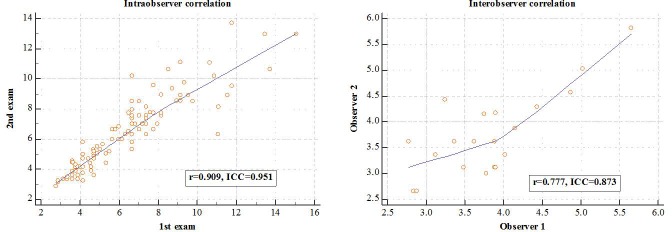
Scatterplots show good intra-and interobserver correlations for 2D comb-push shear wave elastography.The Pearson correlation, r and the intra-class correlation, ICC are shown in the plot.